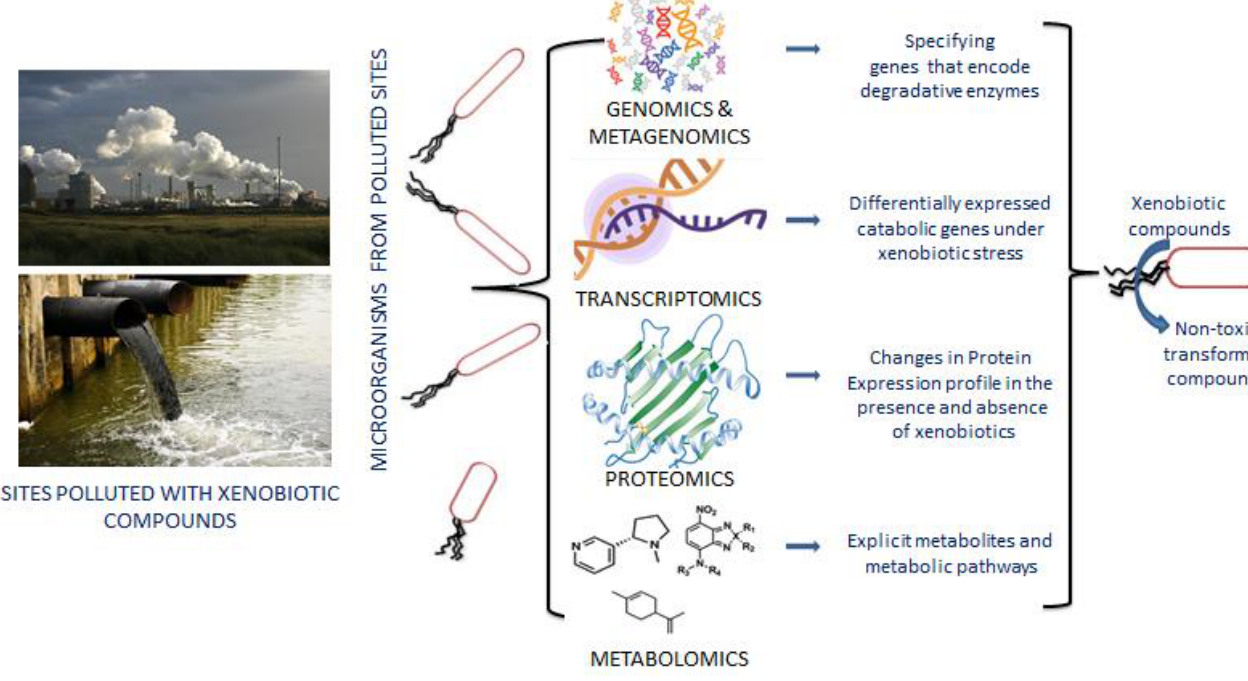
Figure 2. Distinct features of multi-omics technologies in the transformation of xenobiotic compounds. Genomics and metagenomics identify detoxifying enzymes from the whole genome or metagenome sequencing data. RNA seq or transcriptomics data indicate up- and down-regulated genes in response to xenobiotic exposure. Proteomics techniques help to compare the changes in protein profile in the presence and absence of toxic compounds.